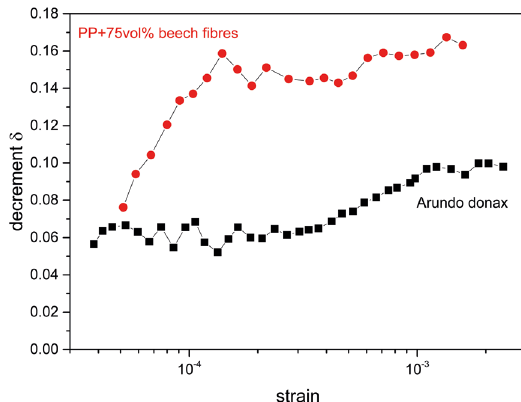
Figure 6. Amplitude dependent internal friction characterized by the logarithmic decrement δ dependent on the strain of Arundo donax and a PP-beech fiber composite at room